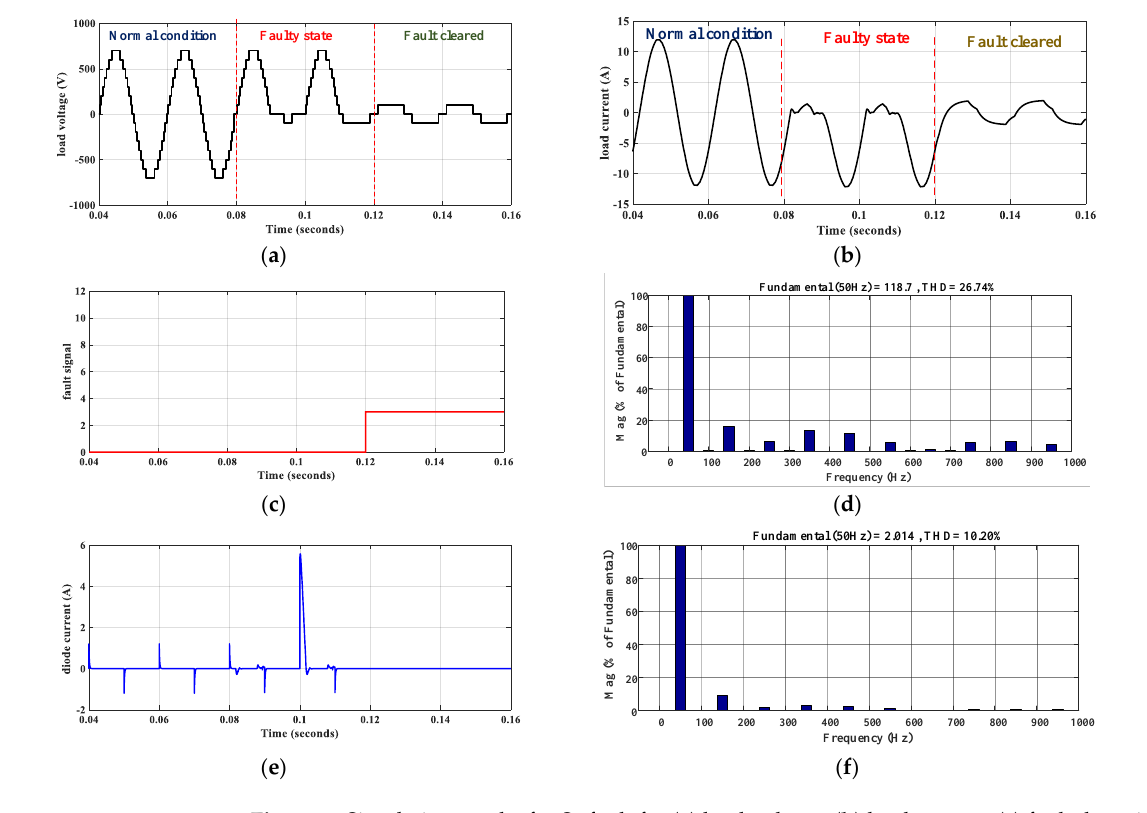
Figure 7. Simulation results for S 3 fault for ( a ) load voltage, ( b ) load current, ( c ) fault detection signal, ( d ) voltage harmonics profile, ( e ) diode current, and ( f ) current harmonics profile. 4.6. S 4 or S 6 Fault Open-circuit failure in S 4 or S 6 leads to loss of levels ±5 V dc , ±6 V dc , ±7 V dc with levels ±V dc , ±2 V dc , ±3 V dc , ±4 V dc prevailing through modulation reconfiguration. The execution of SHE is done post-fault for refining the harmonic profile. The resulting waveforms are displayed in Figures 8 and 9.